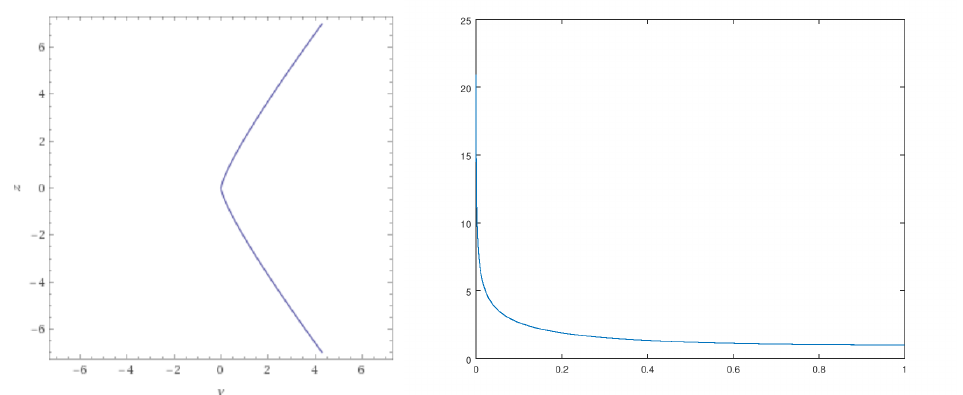
Figure 1. Left : phase portrait; right : solution